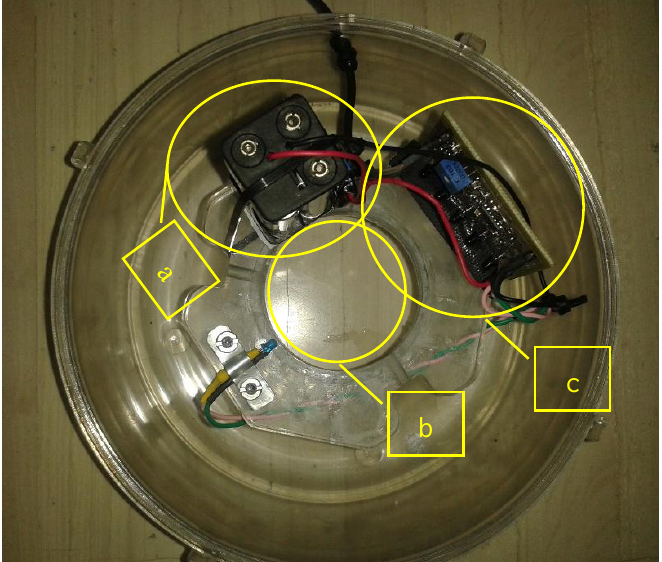
Figure 4. Top view of electronics’ placement. ( a ) A 4.8 Volt battery supply on the left; ( b ) the hole in the middle is the entrance of the inverted funnel; ( c ) the array and the LED in their final positioning. All parts sit tight on a Plexiglas disk mounted on the lower part of the McPhail